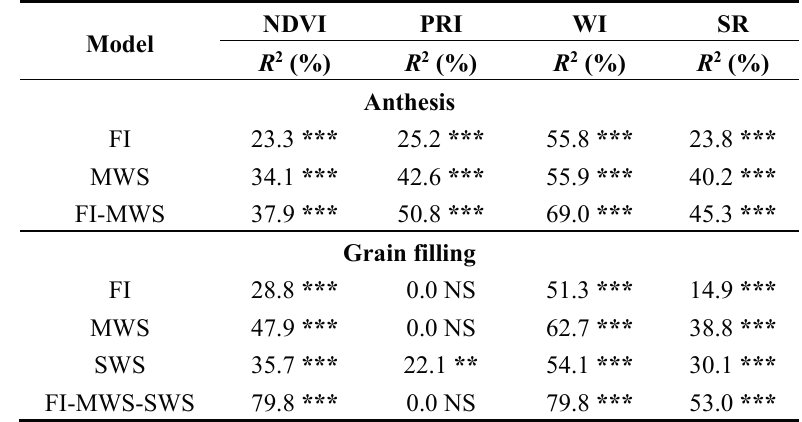
Table 4. Relationships of spectral vegetation indices measured at anthesis and grain filling in three water conditions to grain yield. Values are expressed as coefficient of determination ( R 2